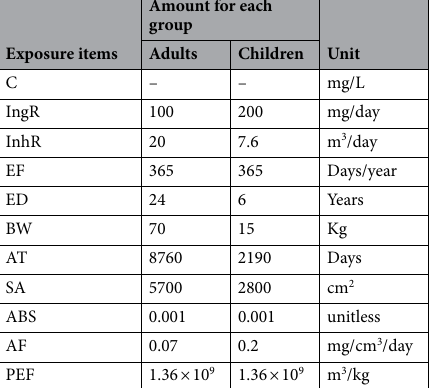
Table 1. Input values for exposure assessment of TEs through ingestion, inhalation and dermal routes 68,69